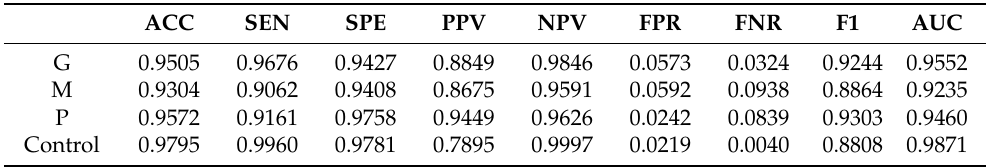
Table 2. Performance metrics of AFF-VGG19 on the brain tumor dataset. G stands for glioma, M for meningioma, P for pituitary.